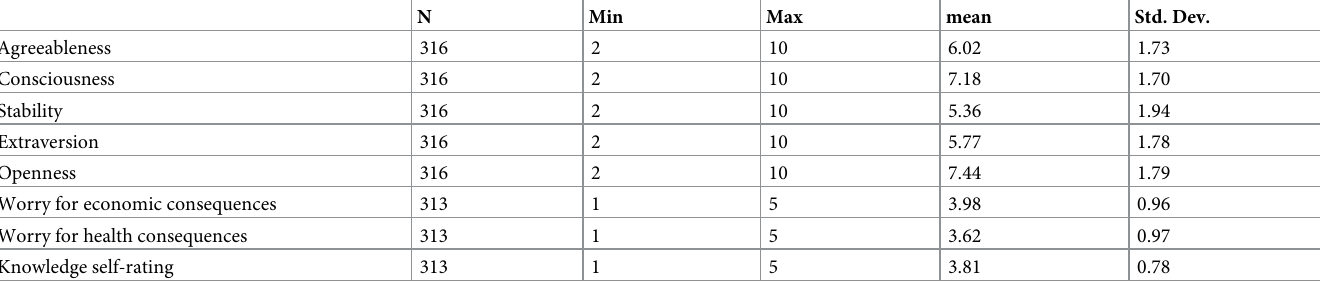
Table 2. Descriptive statistics–personality factors and pandemic-related